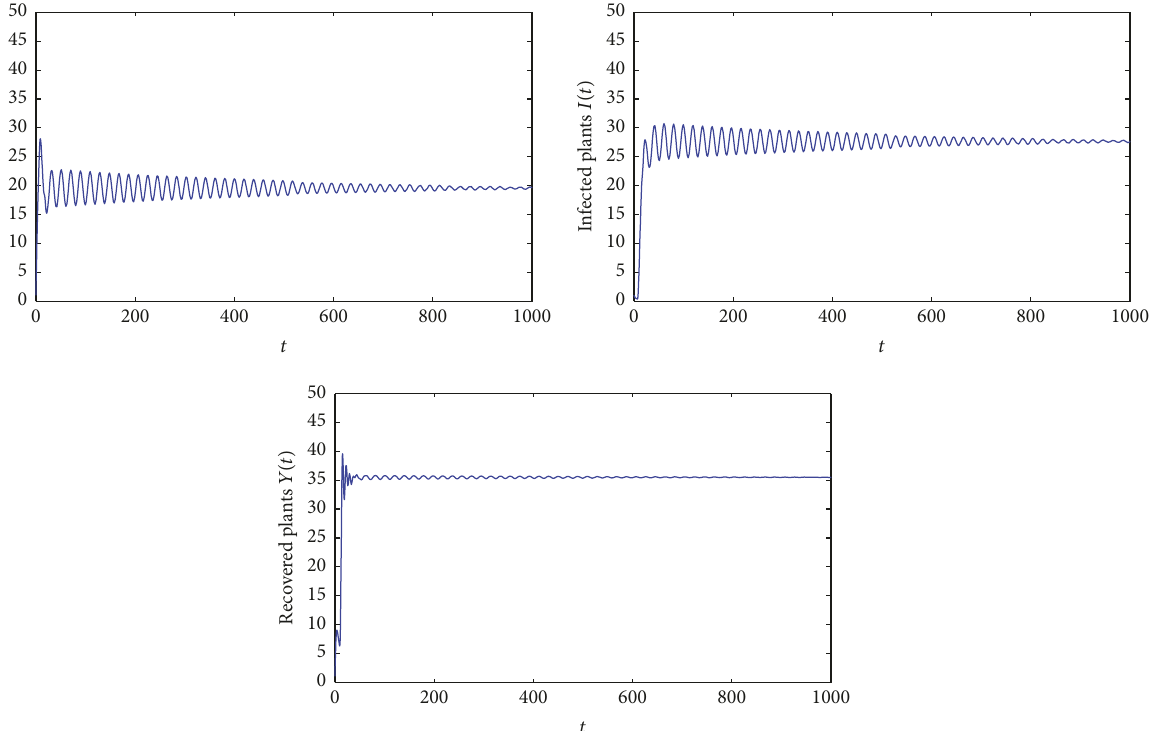
Figure 3: 𝐸 ∗ is asymptotically stable, where 𝜏 1 = 7.1 < 𝜏 10 = 7.4719 and 𝜏 2 = 2